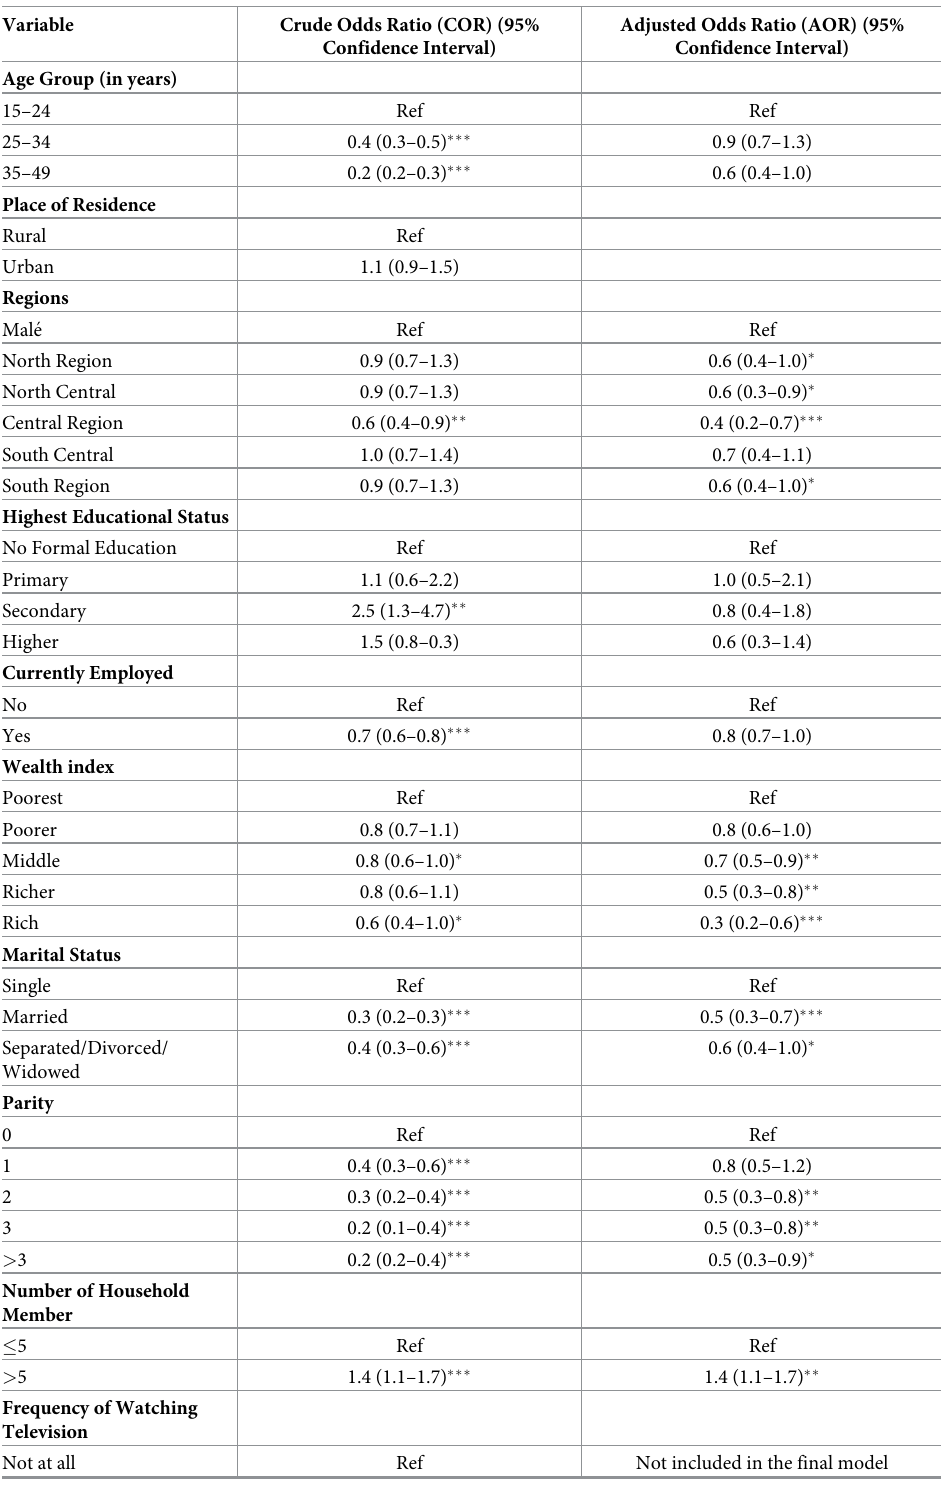
Table 2. Crude and adjusted odds ratio (95% CI) estimates of underweight compared to normal weight by respon- dent background